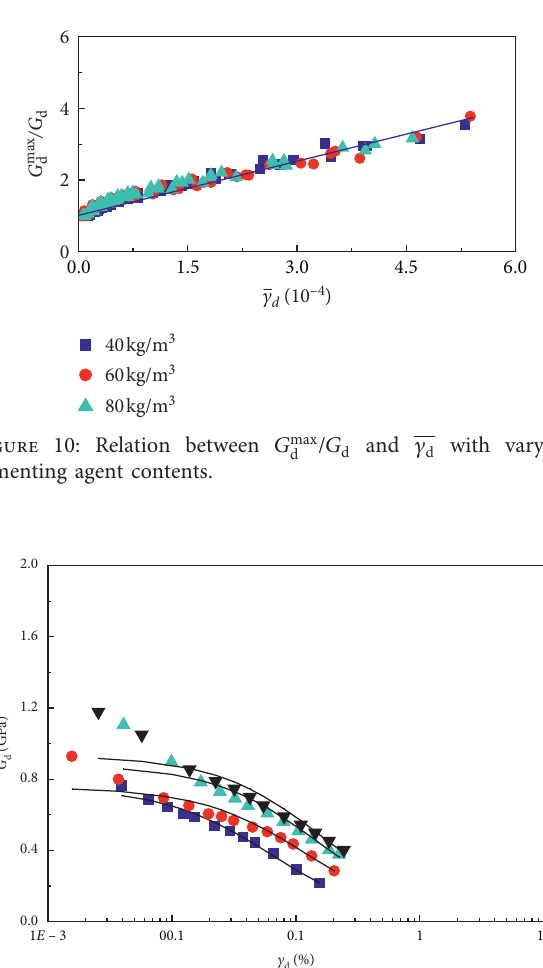
Figure 11: Experimental dynamic shear modulus results and their corresponding calculated